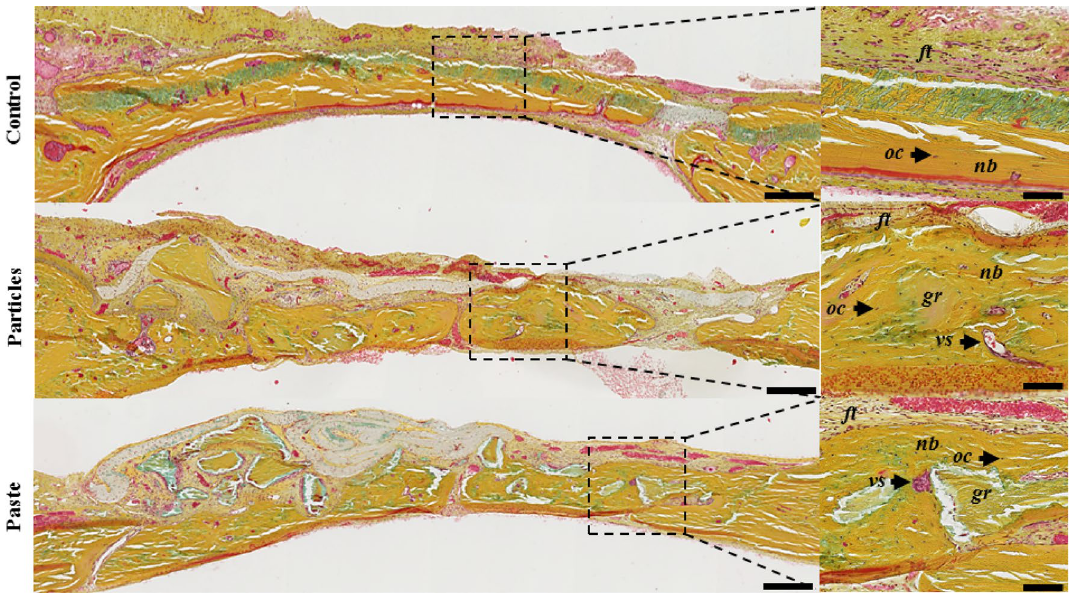
Figure 3. Rat calvaria healing 7 weeks after surgery in a guided bone regeneration model. Representative images of the defects with Movat’s pentachrome staining of undecalcified 7-µm thick frontal sections. The control represents the defects with the GBR membrane without bone grafts (unfilled defects). Scale bars: 250 µm for the histological full defects and 100 µm for the histological magnification (dashed square). Dark yellow: collagen in the bone tissue, light red: cytoplasms, dark red: osteoid borders, brown: nuclei, ft : fibrous tissue, oc : osteocytes, nb : newly formed bone, vs: blood vessels, gr :